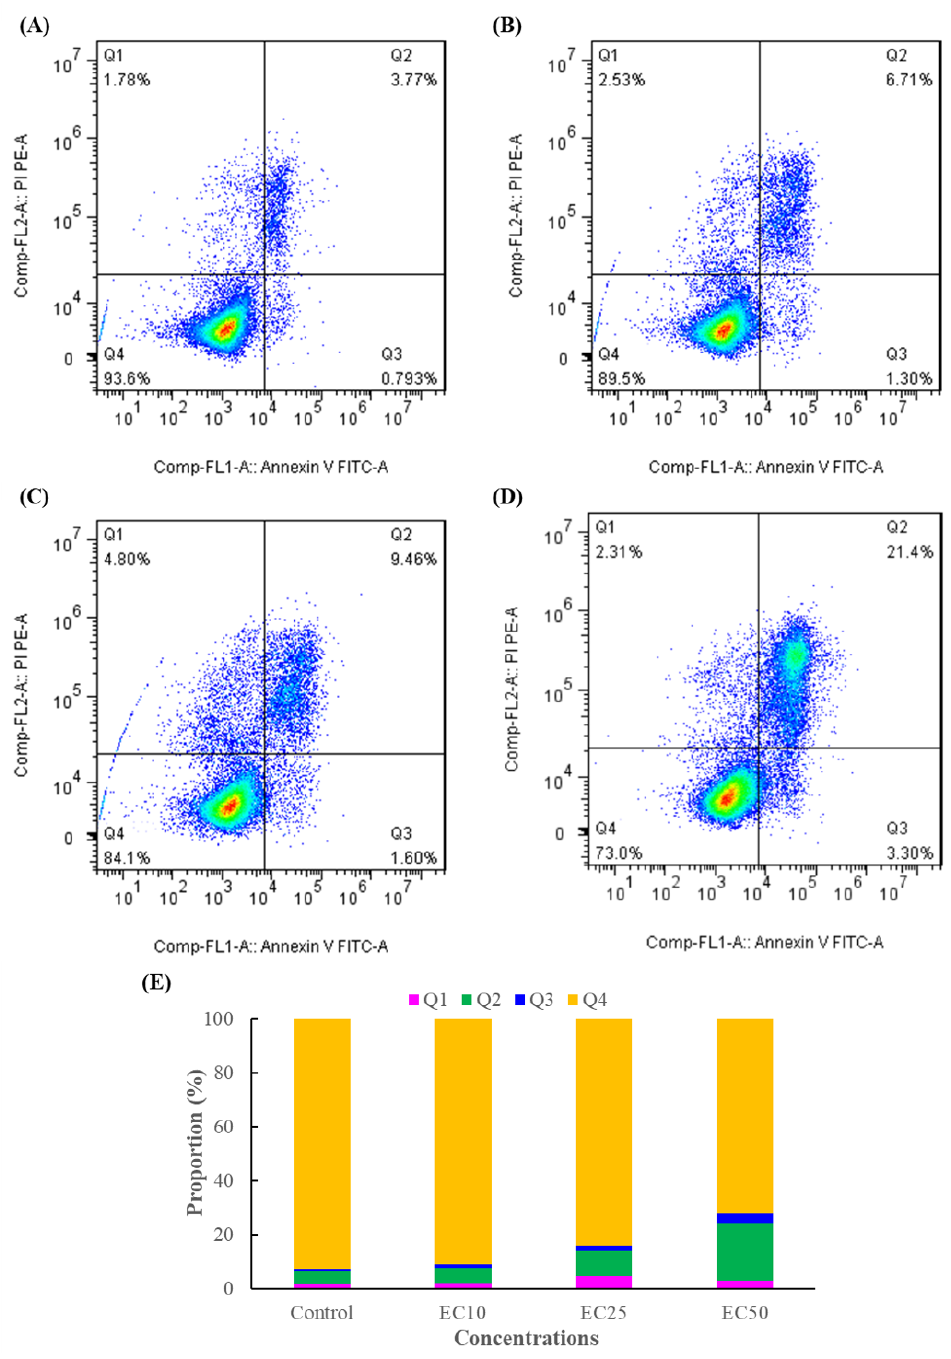
Figure 2. DMM-induced apoptosis in Jurkat T cells. ( A ): Control, ( B ): EC 10 , ( C ): EC 25 , ( D ): EC 50 , ( E ): statistics of the apoptosis data of three independent experiments. Q1, Q2, Q3, and Q4 of the flow cytometry graph indicate dead cells, late apoptotic cells, early apoptotic cells, and normal cells, respectively.